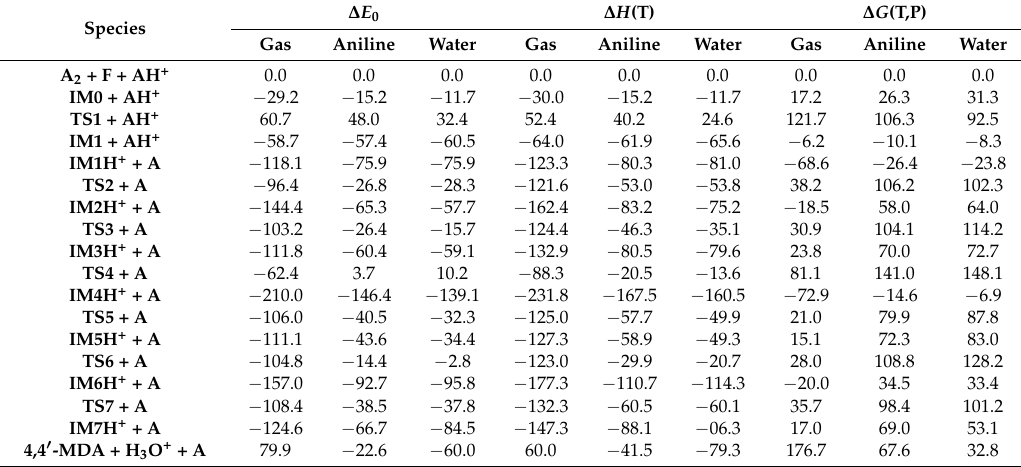
Table 1. G3MP2B3 thermochemical properties calculated in gas phase, in aniline and in water including zero-point corrected relative energies ( ∆ E 0 ), relative enthalpies ( ∆ H (T)) and relative Gibbs free energies ( ∆ G (T,P)) at T = 273.15 K, and P = 1 atm. ∆ E ∆ H (T) ∆ G (T,P) 0 Species Gas Aniline Water Gas Aniline A 2 + F + AH